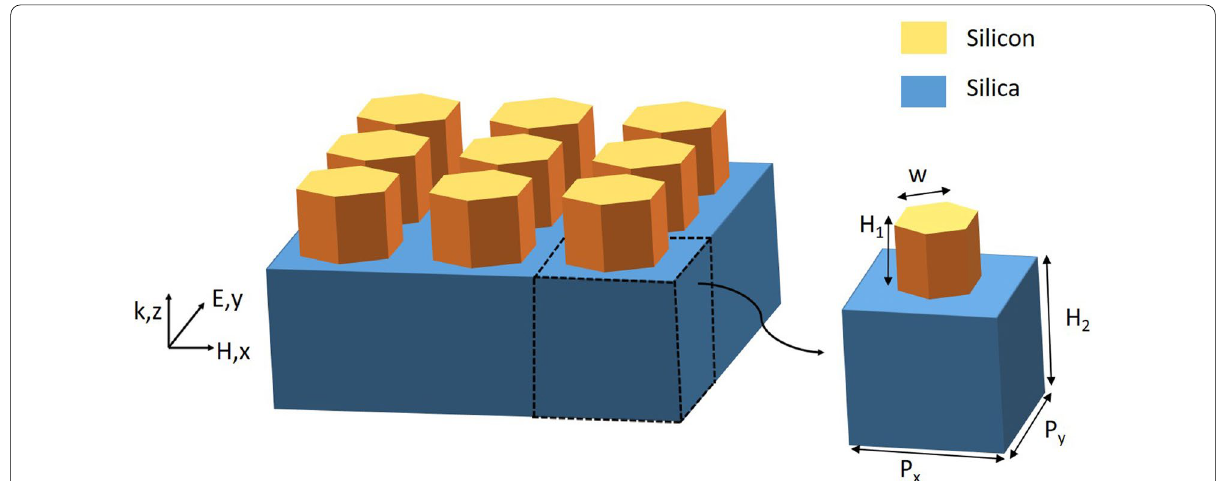
Fig. 1 Schematic of a simple array structure composed of regular hexagonal silicon nanorods on a silica